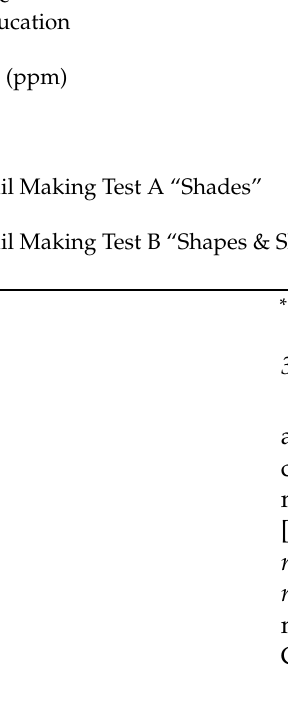
Table 3. Correlation Matrix for All Variables across